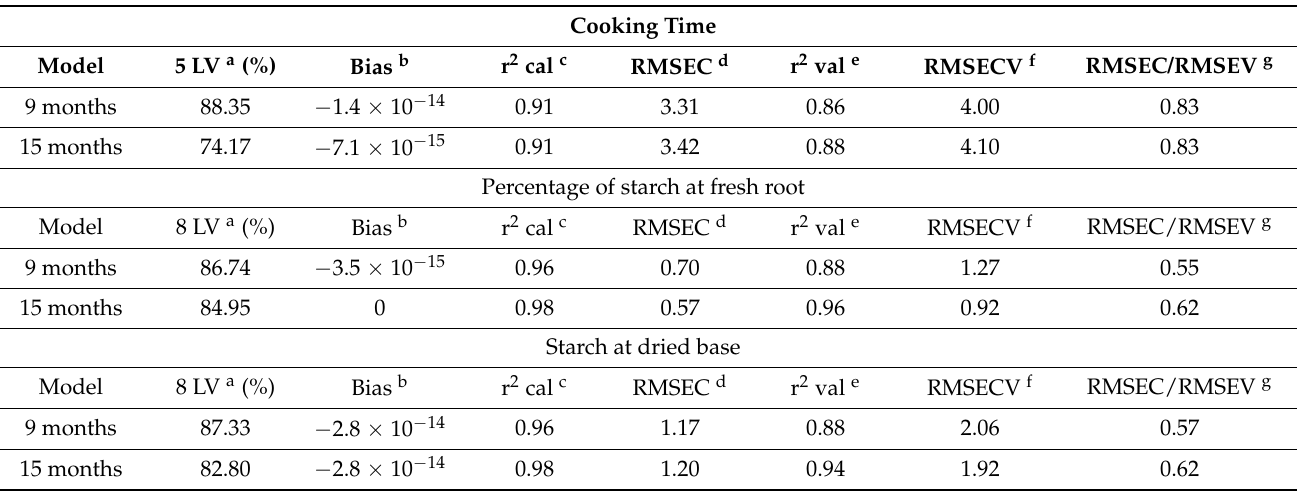
Table 2. Statistical parameters of the multivariate regression from PLS modeling of the cooking time, percentage of starch at fresh root, and starch at dried base according to the cassava aging. Cooking